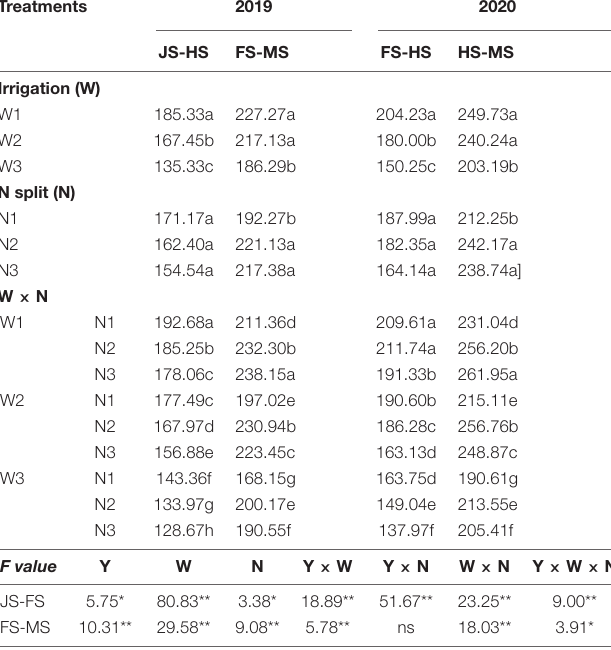
TABLE 4 | Effect of the irrigation methods and N split applications on leaf area duration (LAD).